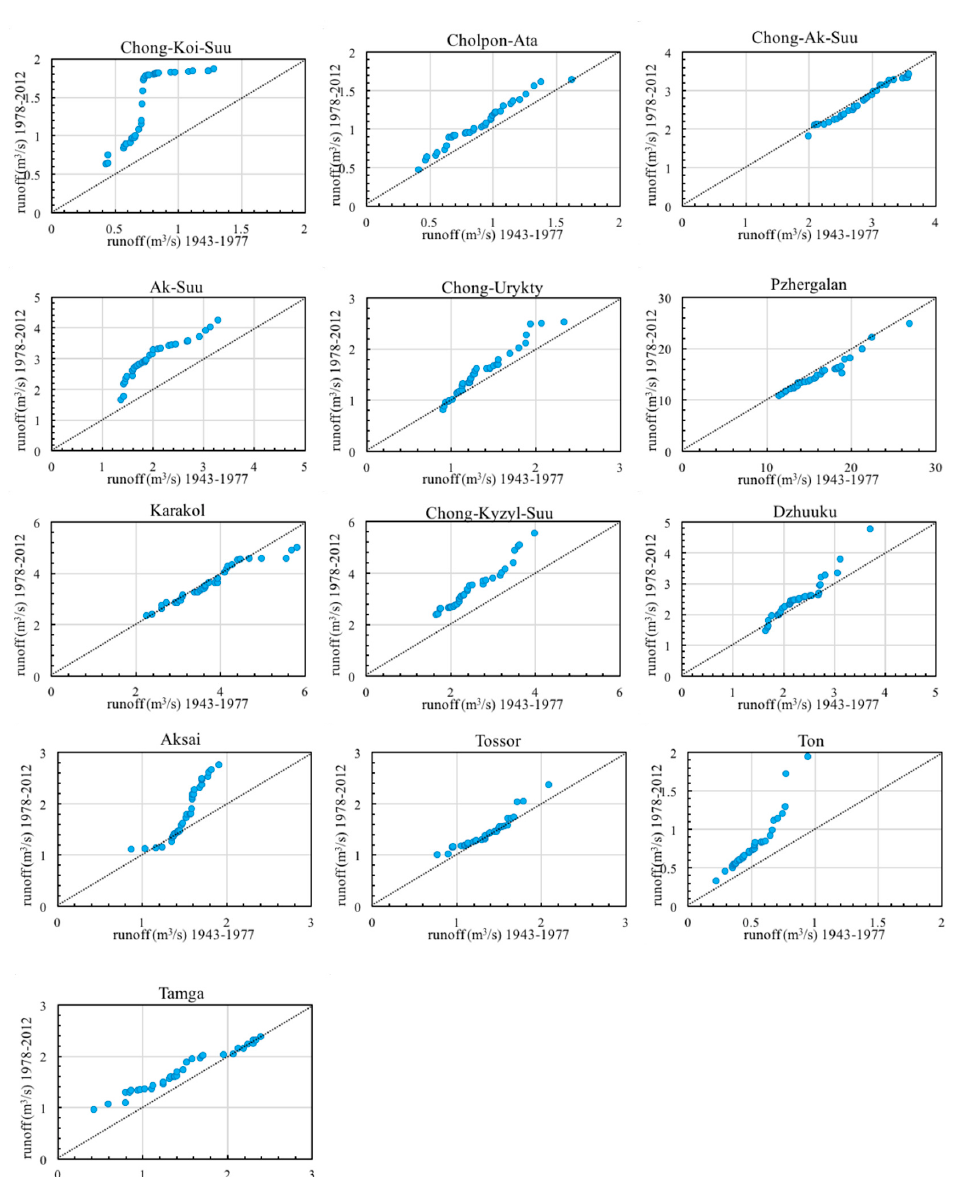
Figure 4. Analysis of the ITA for spring river runoff at 13